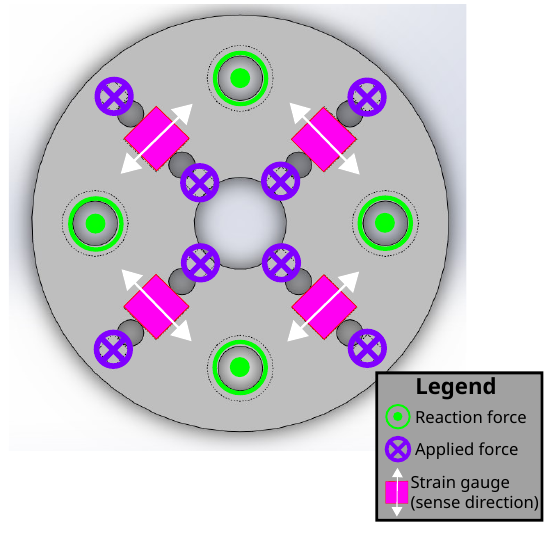
Figure 9. Illustration of applied forces and reaction forces from fixed supports to sensor board, as well as strain-sensing directions. Applied forces in this scenario are all into the page, designated by purple crossed circles. Fixed supports are all out of the page, designated by lime-green dotted